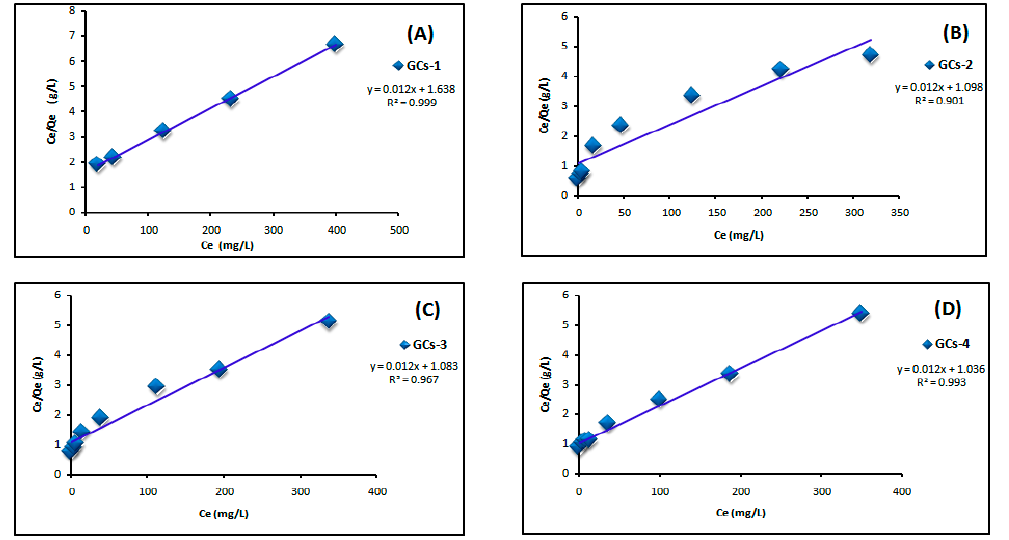
Figure 8. Langmuir isotherm for Cu(II) adsorption using ( A ) GCs-1; ( B ) GCs-2; ( C ) GCs-3 and ( D ) GCs-4.